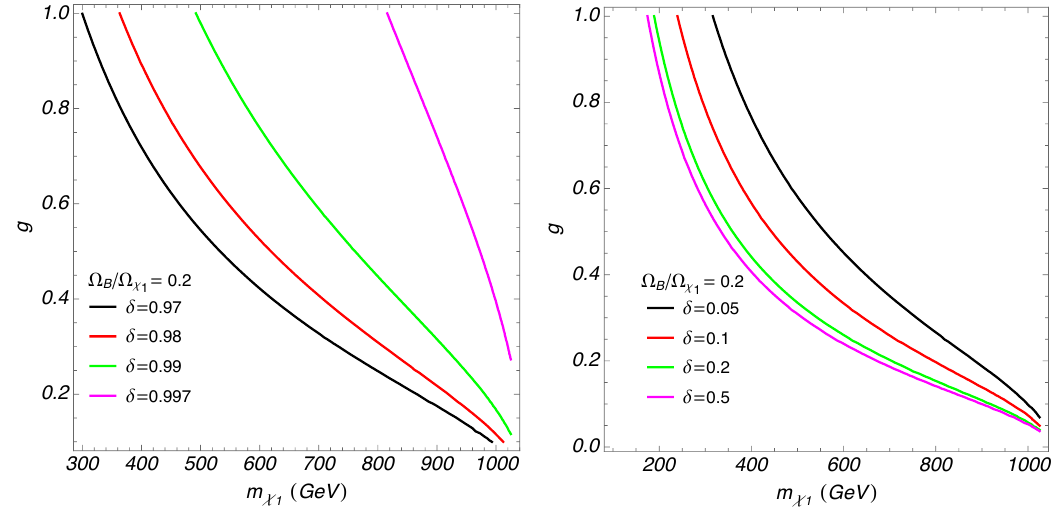
Figure 6 . Contours of constant Ω B / Ω χ = 0 . 2 for varying annihilation coupling g and DM mass 1 m χ and four values of the mass splitting δ in the hierarchical (left) and the nearly degenerate (right) 1 √ scenarios where annihilation is dominantly s -wave with g ≡ g 1 g 2 and/or m A . m S . The other model parameters are pseudoscalar mass m A = 2 . 1 TeV, φ mass m φ = 10 TeV, initial temperature ratio ξ i = 0 . 1 , and χ 3 − quark Yukawa coupling β = 1